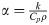
Cryo system supports and thermo-physical properties.In the panel a) the thermo-physical properties of a series of cryo-system supports: thermal conductivity, k, heat capacity, Cp, density ρ and thermal diffusivity, α=kCpρ. In the panel b) the measurement of the cooling and heating processes of a thermocouple mimic the cryo-system support, this data has been previously reported see ref. 1. In panel c) the nylon membranes employed as support.